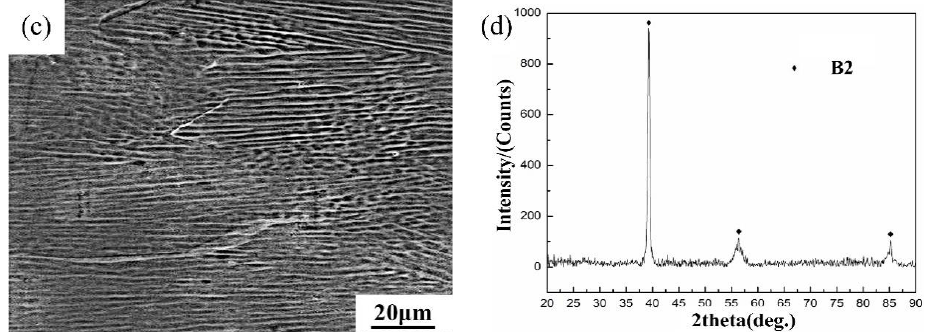
Figure 5. The weld morphology ( a ), EDS result ( b ), weld microstructure ( c ) and XRD result ( d ) of laser welded joint without filler metal. Base metal (BM) and weld zone (WZ) in Figure 5b.